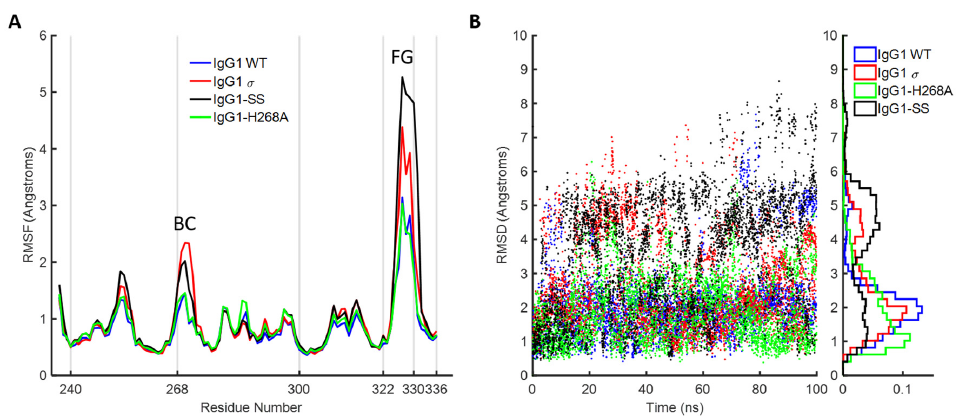
Figure 14. Molecular dynamics simulation of huIgG1 wild-type and mutants. ( A ) Root mean squared fluctuations (RMSF) of C α atoms of chain B of C H 2 domain. The trajectories are aligned on the C α atoms with respect to the non-BC and non-FG loop residues of chain B of C H 2 domain of the corresponding crystal structures. The peaks corresponding to the BC and FG loop are marked. The two loops are more flexible in huIgG1 σ (red) as compared to wild-type (blue). The fluctuations in huIgG1-H268A (green, containing only the BC loop mutation) are closer to wild-type while those in huIgG1-SS (A330S P331S) (black, contains only the FG loop mutations) are closer to the silent variant. ( B ) Root mean squared deviation (RMSD) of the C α atoms of the FG loop with respect to the flipped-in conformation. RMSD values are shown for all frames of the 100-ns trajectory. The right panel shows a normalized histogram of the RMSD values.